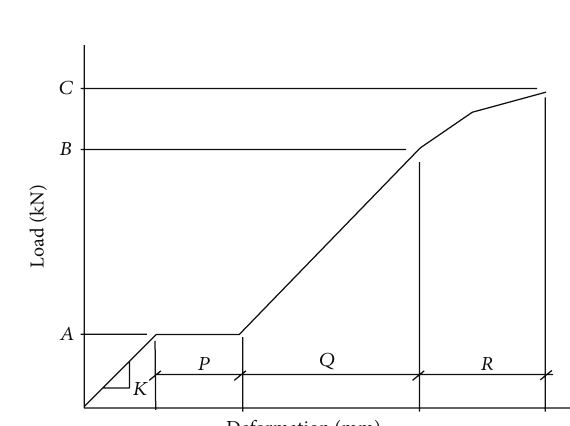
Figure 2: Ungkurapinan et al. single-leg bolted joint [18].